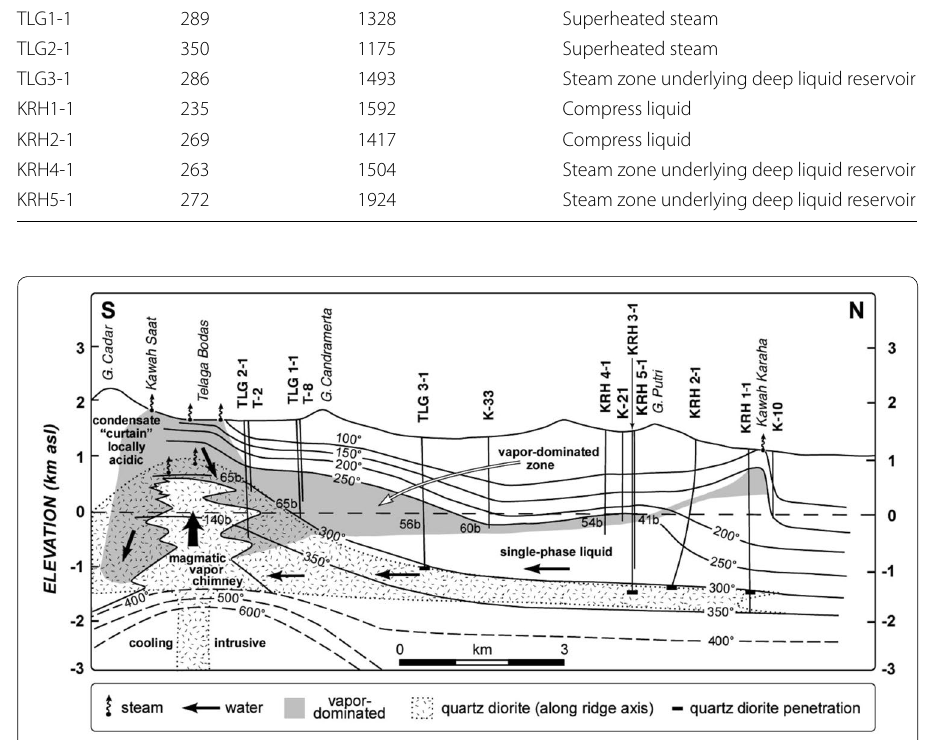
Fig. 5 Conceptual model of Karaha–Talaga Bodas (Allis et al.